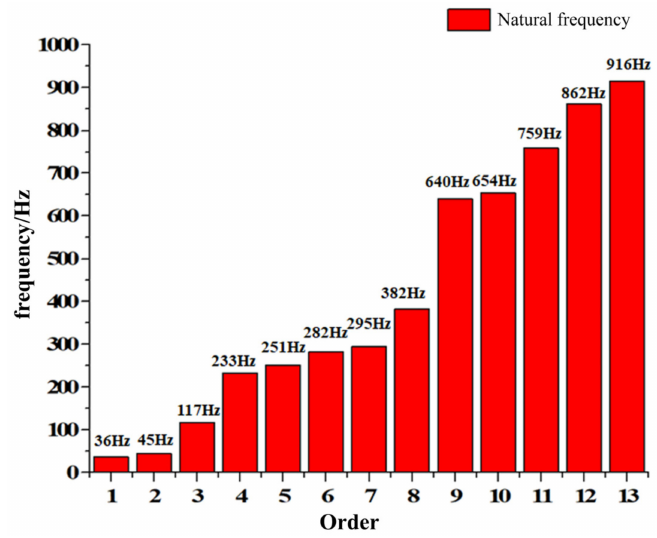
Figure 6. The natural frequency of the pump unit.